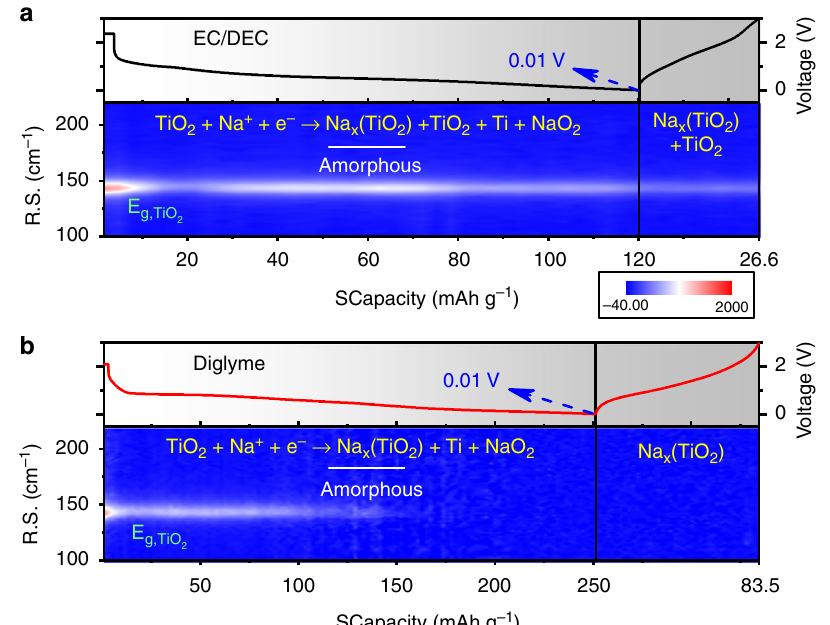
Fig. 2 In operando Raman spectroscopy. Raman spectra of the TiO 2 anode during the fi rst cycle of electrochemical sodiation/de-sodiation at a rate of 100 mA g − 1 (R.S.: Raman shifts), a using the EC/DEC-based electrolyte and b using the diglyme-based electrolyte